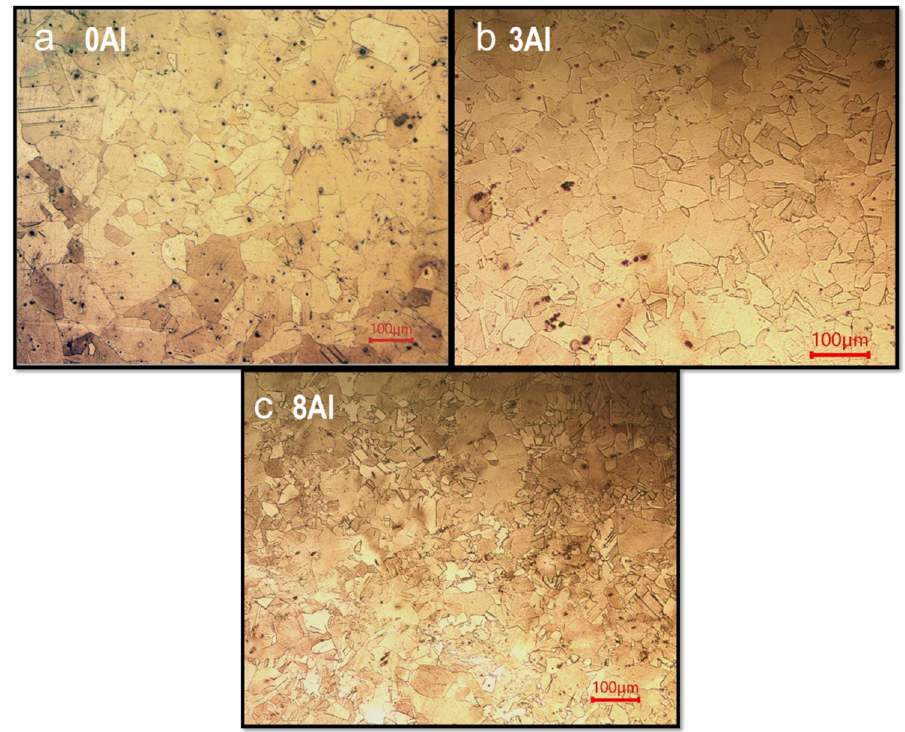
Figure 3. Microstructures at 100 × of the ( a ) 0Al; ( b ) 3Al; ( c ) 8Al alloys.